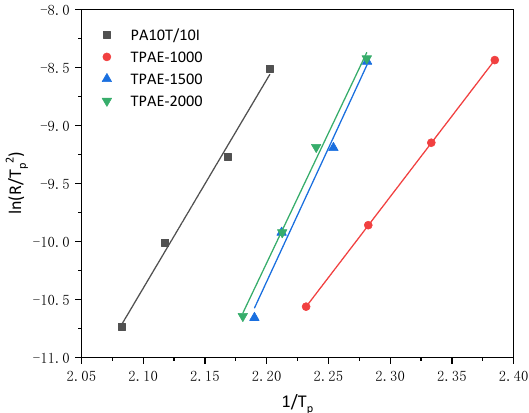
Figure 13. Kissinger plots for evaluating non-isothermal crystallization activation energy of TPAEs and PA10T/10I.